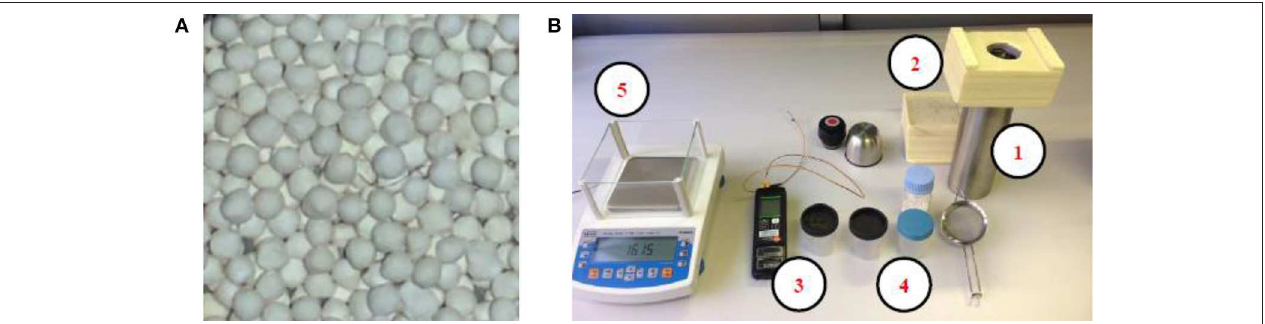
FIGURE 1 | (A) Sample of the commercial 13X zeolite used in the experimental characterization as sorbent material: Köstrolith ® 13XBFK by Chemiewerk Bad Köstritz GmbH (CWK-BK datasheets, 2019). (B) Overview of the material and instruments used for the experimental characterization of the sorption working pairs: (1) Dewar flask, (2) insulated tap, (3) K-type thermocouple, (4) zeolite containers, (5) precision